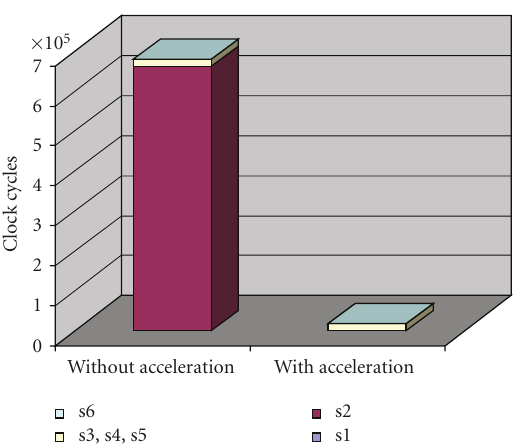
Figure 6: Comparison of the cost in clock cycles of executing the entire algorithm (Steps 1–6) of Section 2 for one mutation using floating point representation (we decided not to compromise on the accuracy of the results), with and without hardware acceleration.